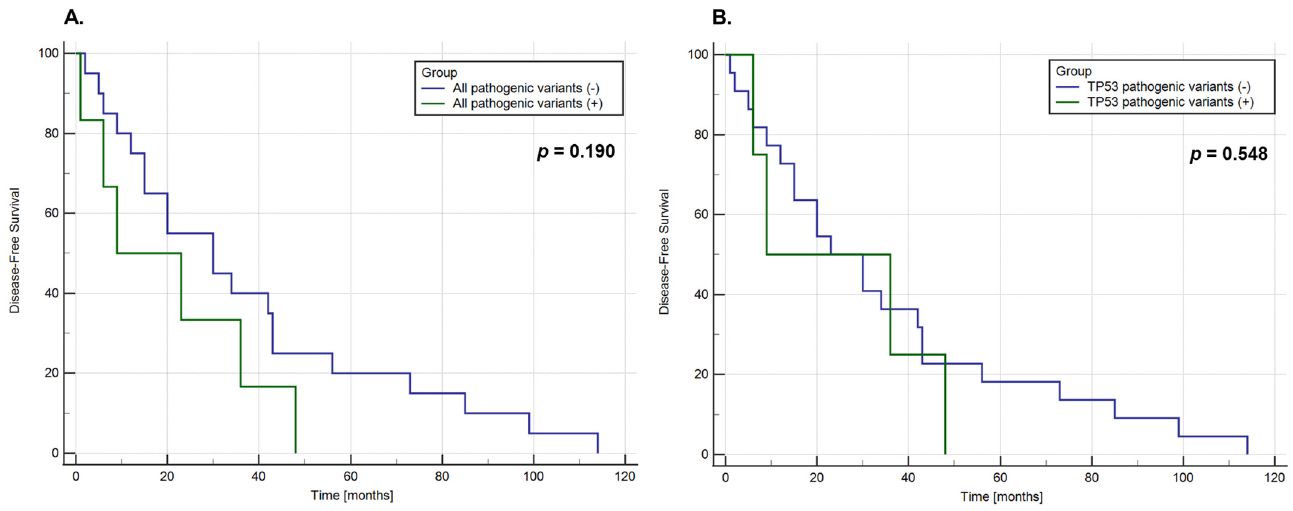
Figure 2. The Kaplan-Meier and Log-Rank test analysis of disease-free survival (DFS) in 34 patients with thymic carcinomas according to the presence of any pathogenic SNV found within 15 genes ( A ) or the presence of pathogenic SNV in TP53 gene ( B ).